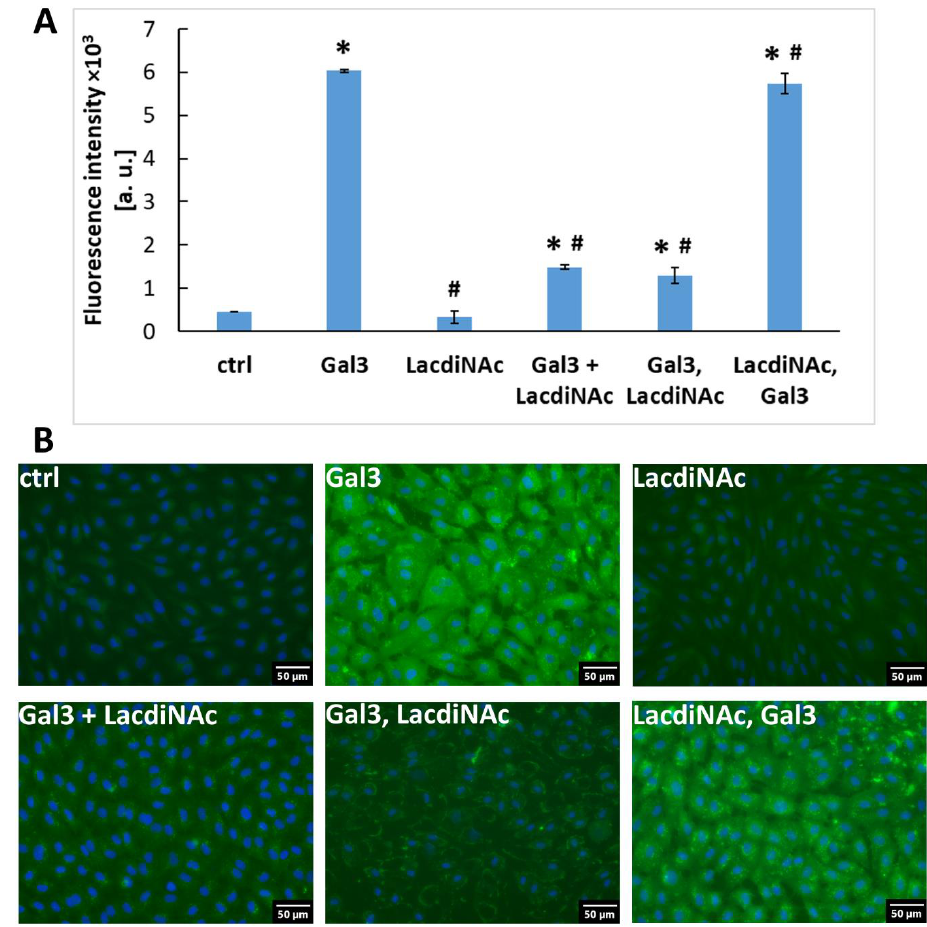
Figure 4. HUVECs after incubation in a cultivation medium containing Gal-3 (30 μM) or LacdiNAc (1 mM) or both molecules added together or in a different order. Control cells were incubated for 1 h in a pure cultivation medium. ( A ) Intensity of the fluorescence signal in HUVECs stained for Gal-3 (ex./em. = 485/528 nm). The data are shown as the mean ± SD from 3 wells. Holm-Sidak test, p ≤ 0.05. * Statistically significant difference in comparison with cells in the pure medium (ctrl), # Statistically significant difference in comparison with cells incubated with Gal-3 (Gal-3). ( B ) Immunofluorescence of Gal-3 in the cells compared in graph A. Anti-Gal-3 antibody (EP2775Y) produced in rabbits (Abcam, Cambridge, UK; Cat. No. ab76245) was used. The cell nuclei were counterstained with Hoechst 33258. Olympus IX 71 microscope, DP 70 digital camera, obj. 20 × , scale bar 50 µ m. Ctrl: cells in the pure medium; Gal3: cells incubated for 1 h in the medium with Gal-3; LacdiNAc: cells incubated for 1 h in the medium with 1-mM LacdiNAc; Gal3 + LacdiNAc: cells incubated for 1 h in the mixture of Gal-3 and LacdiNAc; LacdiNAc, Gal3: cells incubated for 1 h in the medium with LacdiNAc, then for 1 h in the medium with Gal-3; Gal3, LacdiNAc: cells incubated for 1 h in the medium with Gal-3, then for 1 h in the medium with